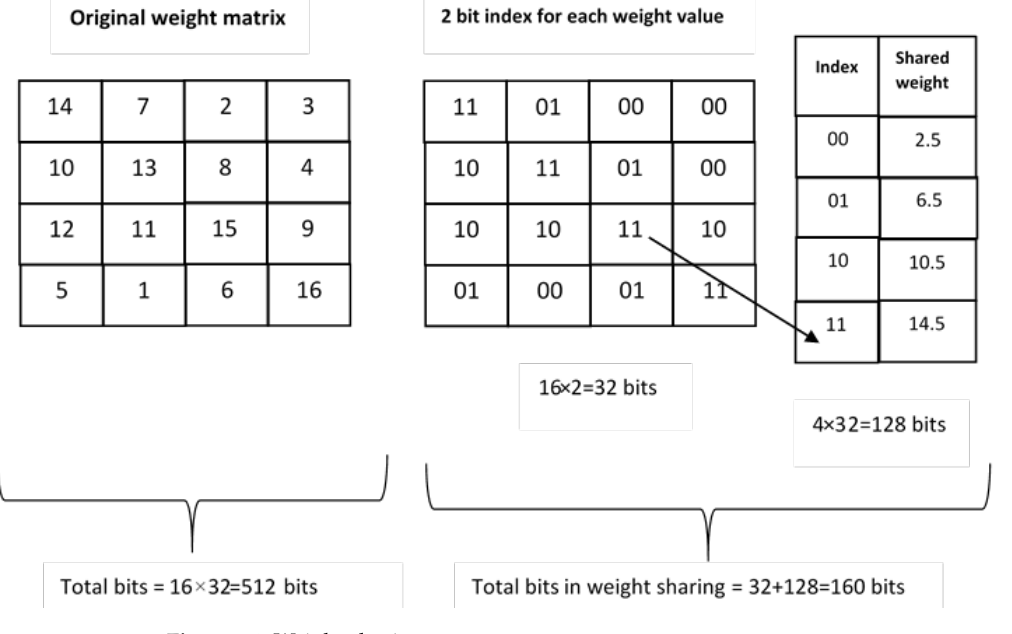
Figure 14. Weight sharing. Figure 14. Weight